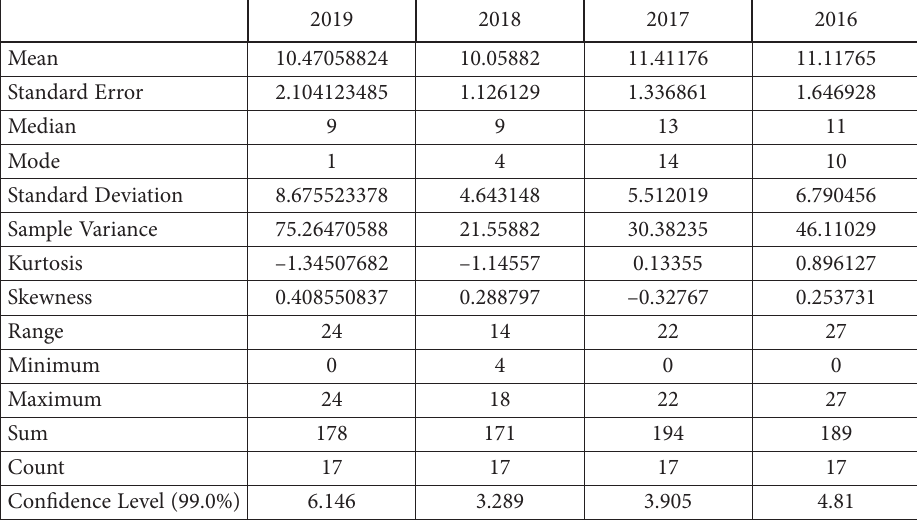
Table 3. The summary of the descriptive statistics of analysed data on